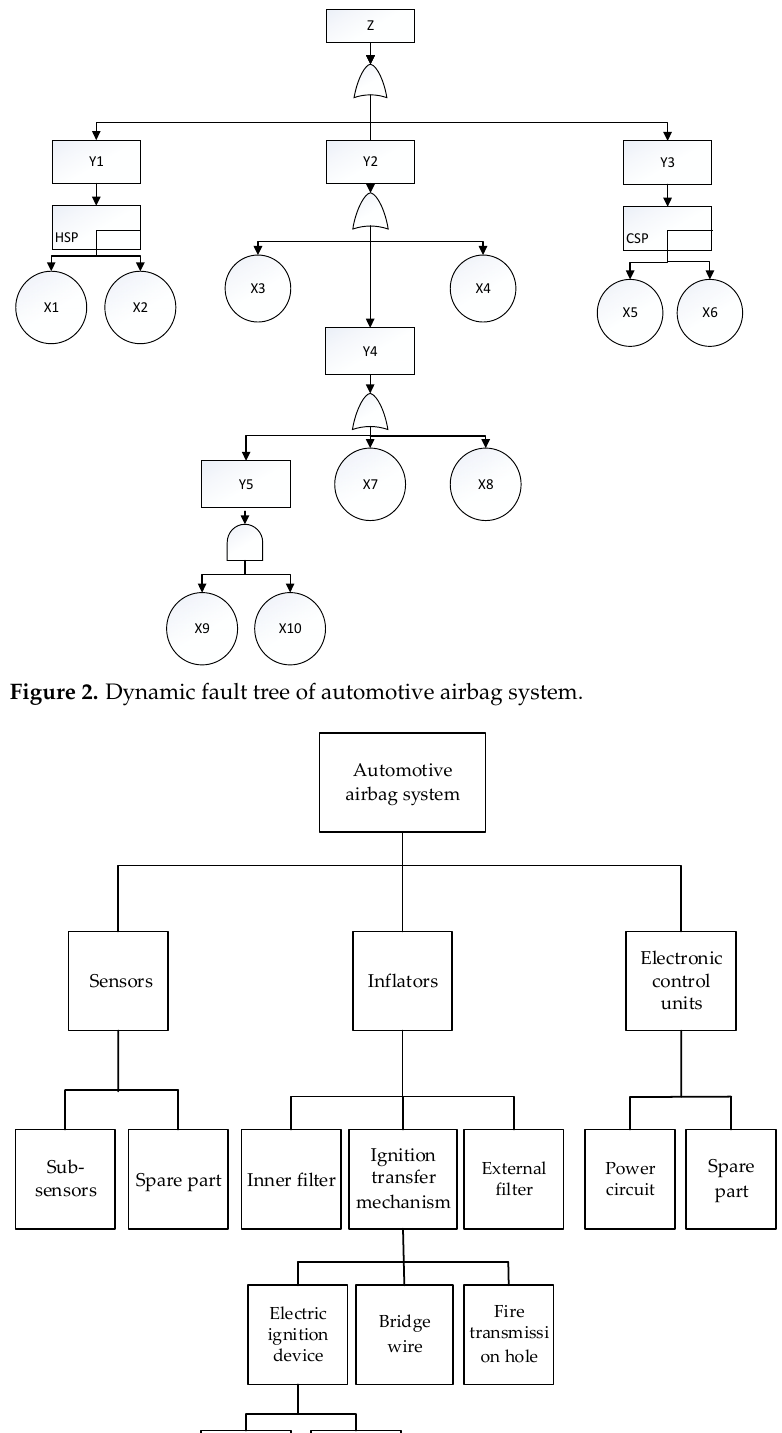
Figure 3. System structure of automotive airbag